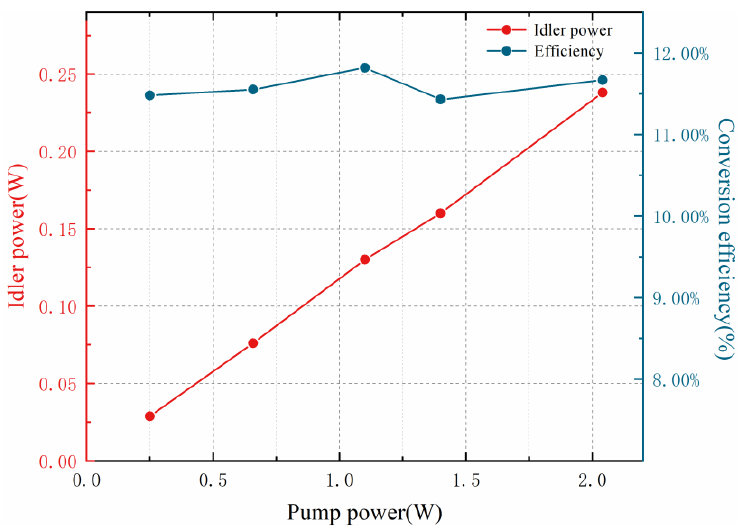
Figure 6. Measured 3713 nm broadband idler power and pump – idler conversion efficiency.